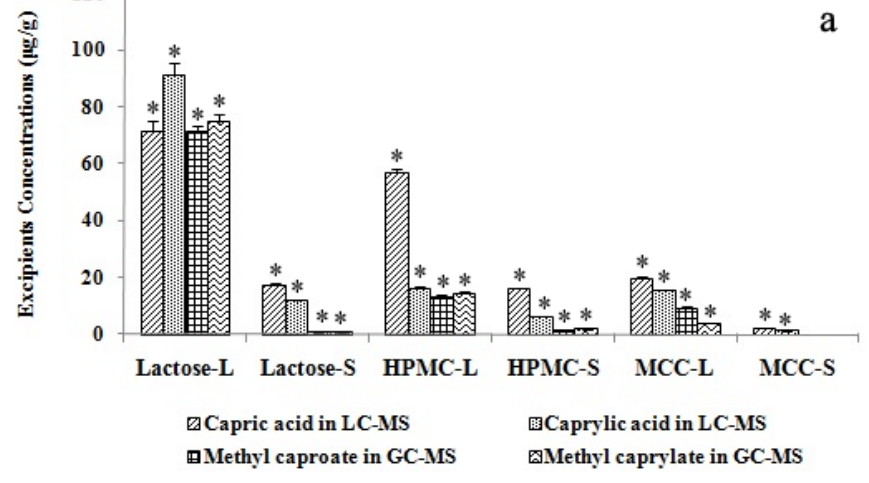
Figure 5. Concentrations of Labrasol and Transcutol in SMEDDS of scutellarin. Labrasol ( a ) and Transcutol ( b ) concentrations were analyzed by LC- and GC-MS (n = 4, * p < 0.05). Lactose-L, HPMC-L and MCC-L represent liquid SMEDDS containing lactose, HPMC and MCC; while lactose-S, HPMC-S and MCC-S are for solid SMEDDS with lactose, HPMC and MCC as solid carriers. * denotes p <